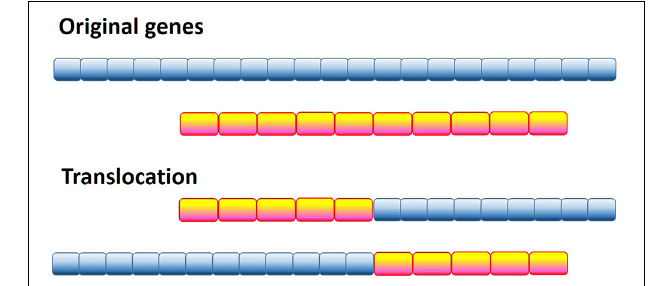
FIGURE 1 | Schematic representation of different ways by which aberrant regulation at the genetic level or various posttranslational (non-genetic) mechanisms can cause pathogenic transformation in an IDP/IDPR.